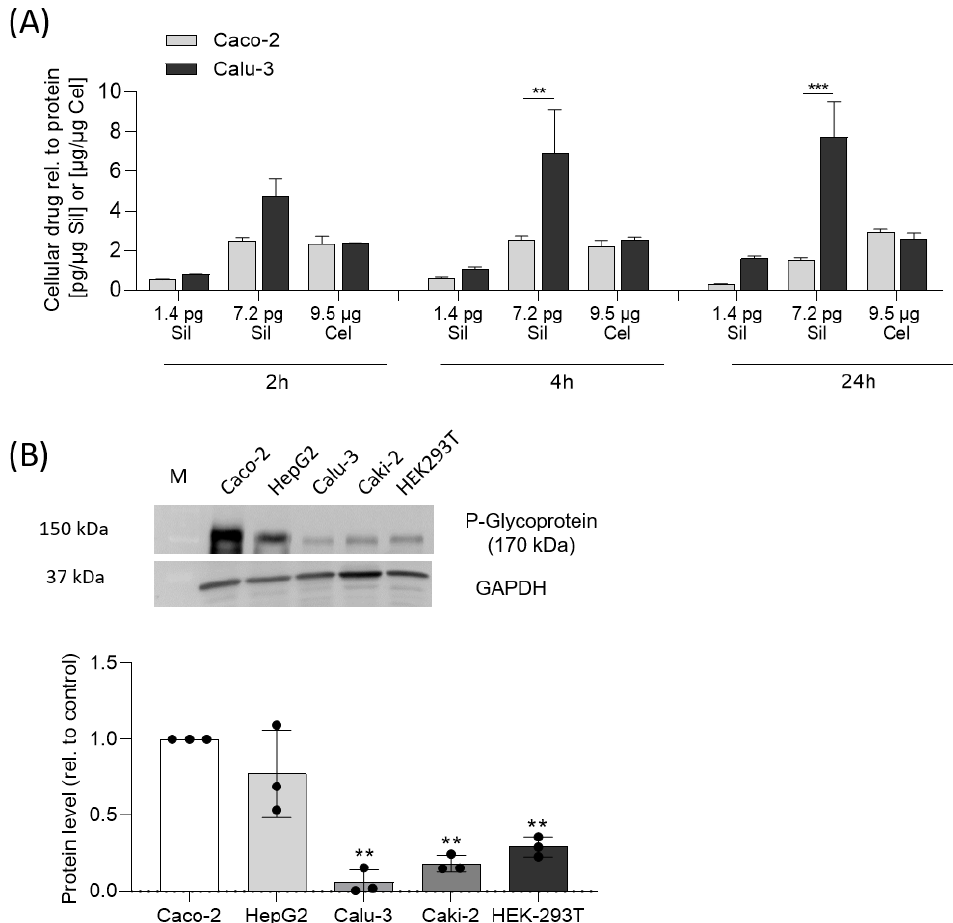
Figure 5. Cellular uptake assay. ( A ) Caco-2 or Calu-3 cells were incubated with two concentrations of silvestrol (5 nM, 25 nM) or 25 µ M celecoxib (positive control) for the indicated time periods. The concentrations of the compounds were determined by LC-MS/MS. The concentration of drugs in the cells was related to the protein concentration. The experiments were performed in biological triplicates. Data are expressed as mean ± SEM. For statistical analysis, two-way ANOVA with Sidak’s multiple comparisons test was used. *** p < 0.001 indicate significant differences between Caco-2 and Calu-3 samples. ( B ) P-glycoprotein level was detected by Western blot and analyzed by the optical densitometric analysis achieved with the Image Lab software version 6.0 (Bio-Rad Laboratories, Hercules, CA, USA). The molecular weight of P-glycoprotein is 170 kDA including 10–25 kDa of N-terminal glycosylation. The protein level was normalized to GAPDH and related to the P-glycoprotein level of Caco-2 cells. Data are expressed as mean ± SEM. For statistical analysis, the relative P-glycoprotein level of the various cell lines was compared to the expression in Caco-2 cells using one-way ANOVA with Dunnett’s multiple comparisons test. ** p < 0.01 indicate significant